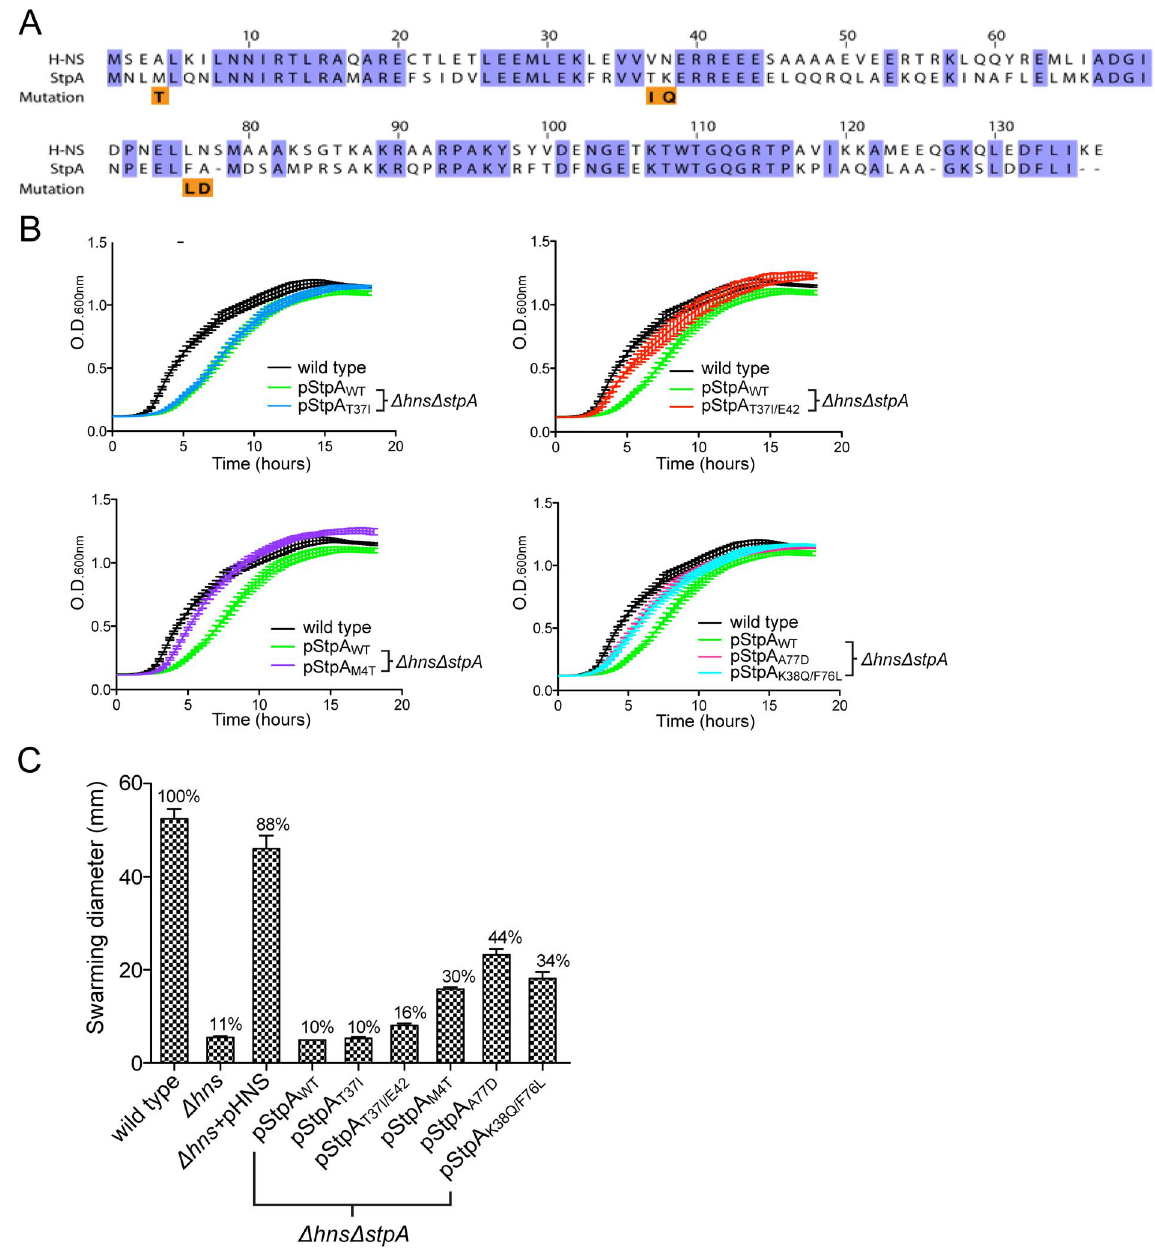
Figure 5. Missense mutations in the H-NS paralogue StpA partially restore the impaired growth and motility phenotypes of hns mutants. (A) Sequence alignment of H-NS and StpA from S. Typhimurium, conserved residues are highlighted in purple. The StpA amino acid substitutions acquired throughout the hns mutant passaging are indicated below the alignment in orange. (B) Plasmids harboring the StpA variants isolated from the passaged D hns lineages were introduced into a D hns/ D stpA background and growth of the resulting strains was monitored in a 96- well plate reader. The wild type (black) and D hns/ D stpA strain expressing StpA WT (green) growth curves are the same in each panel. (C) Swarming motility of the same strains used in the growth assays were measured on soft agar plates following a 12 hour incubation period at 37 u C. Expression of StpA T37I/E42 , StpA M4T , StpA A77D and StpA K38Q/F76L restored motility by 16%, 30%, 44% and 34% respectively. Bars represent the average swarm diameter of three independent experiments and error bars represent the standard error.